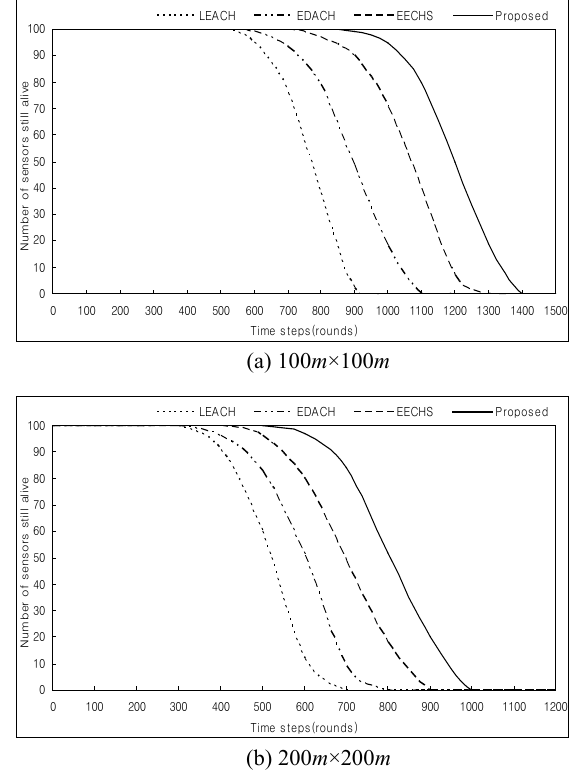
Fig. 5. The comparison of network